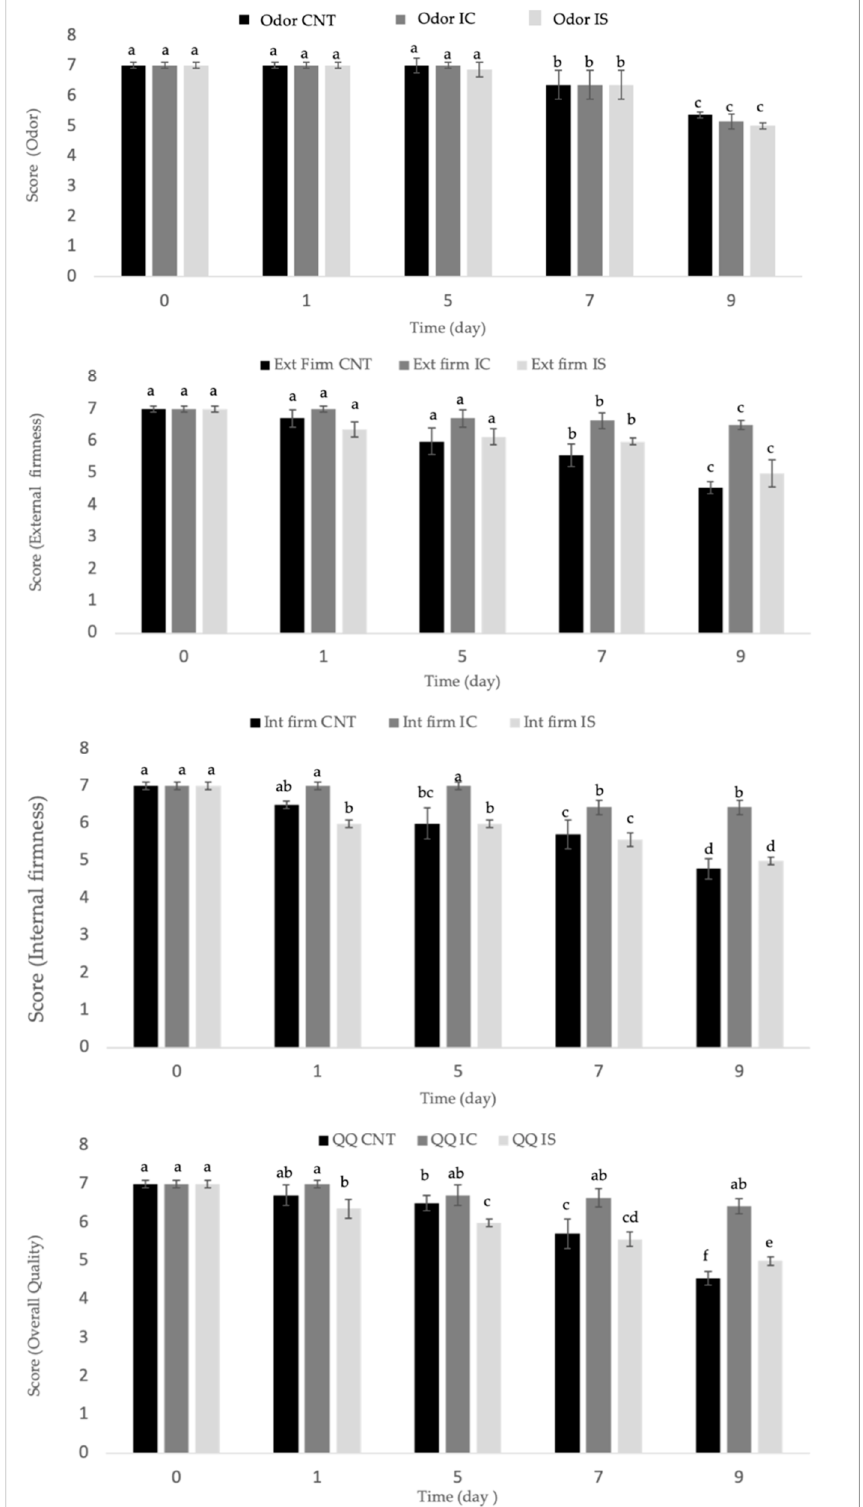
Figure 3. Odor, firmness and overall quality of fiordilatte. Values are means of four replications ± standard deviation. CNT: control; IC: fiordilatte with inulin from chicory; IS: fiordilatte with inulin from cardoon. Values are means ± standard deviation. a–f : means of each parameter with different letters are significantly different ( p < 0.05).